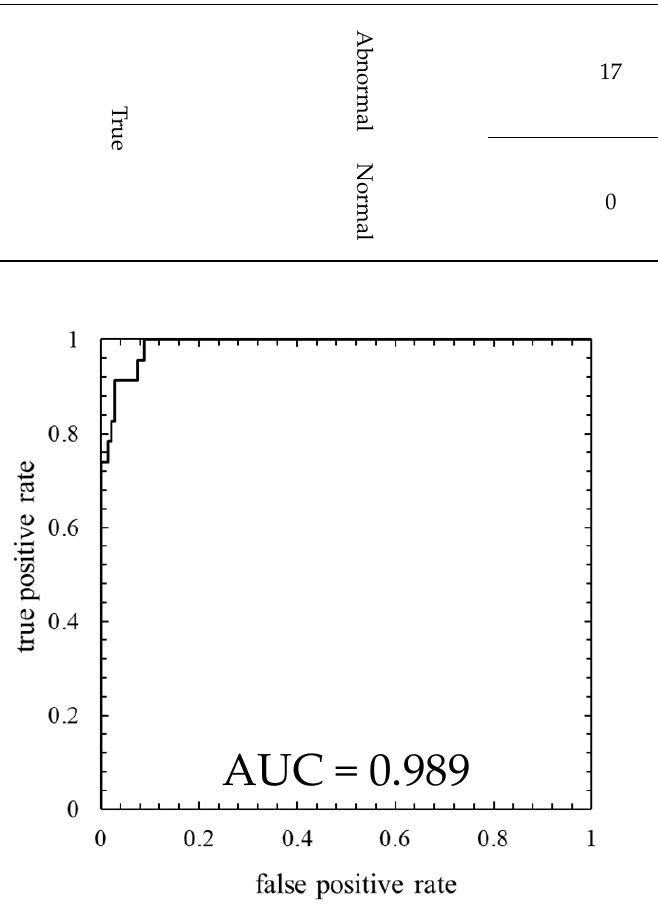
Figure 6. ROC curve of the model in which the number of mixture components K was determined based on BIC ( K = 29, the threshold is the 99th percentile’s value).